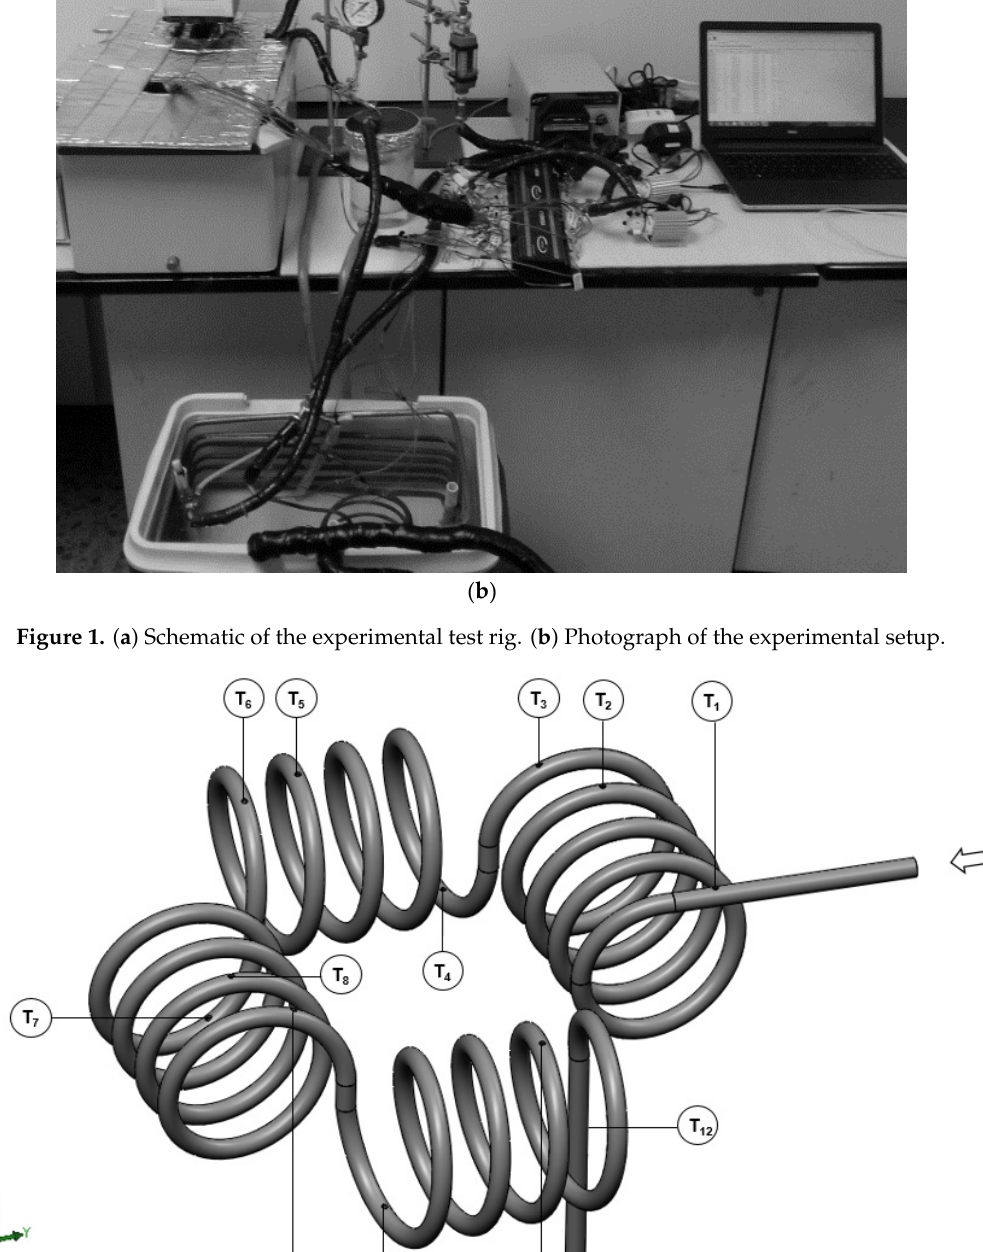
Figure 2. Schematic of the test section and the thermocouple locations. Arrows indicate the flow direction of the fluid.